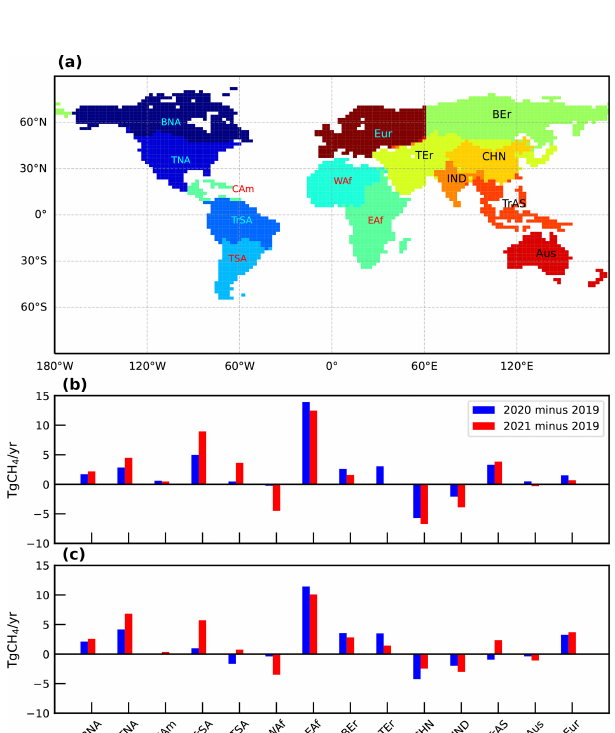
Figure 1. (a) Large-scale geographical regions for which we re- port methane changes (TgCH 4 yr − 1 ) in 2020 and 2021. (b) Dif- ferences between a posteriori emissions from 2020 and 2021 rel- ative to inversion-specific baselines for 2019. Geographical re- gions, informed by TransCom–3 experiments (Gurney et al., 2004), include boreal North America (BNA), temperate North America (TNA), central America (Cam), tropical South America (TrSA), temperature South America (TSA), Europe (Eur), Western Africa (WAf), Eastern Africa (EAf), boreal Eurasia (BEr), temperate Eura- sia (TEr), India (IND), China (CHN), tropical Asia (TrAs), and Aus- tralia (Aus). Panel (c) is the same as (b) but for a posteriori methane emission from the joint methane–OH